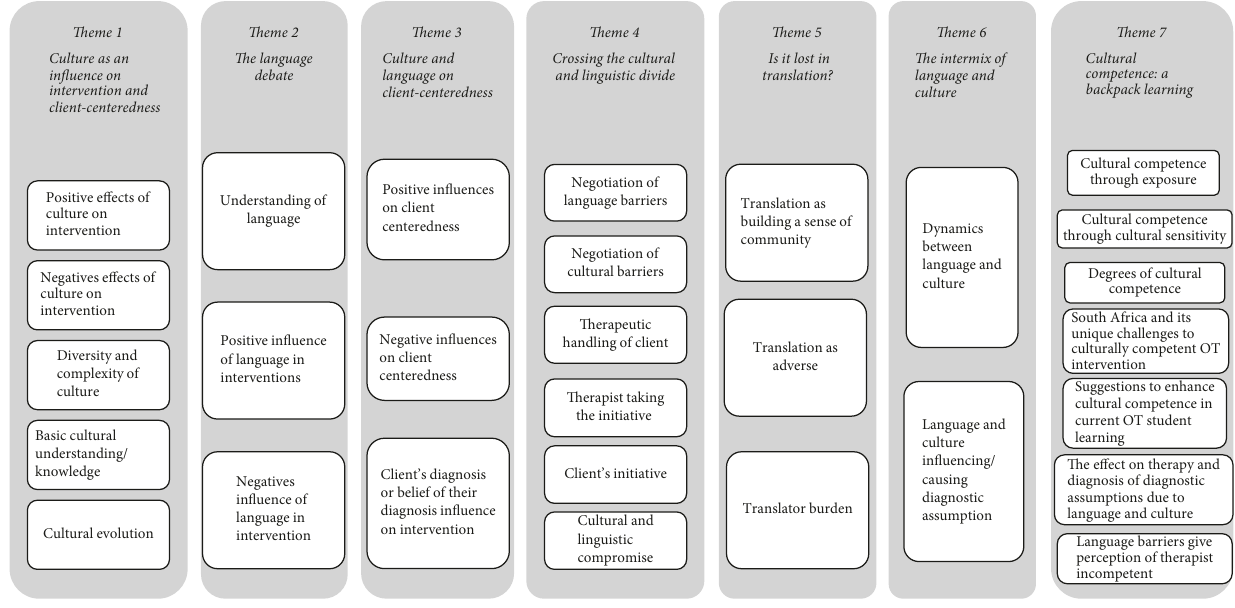
Figure 4: Themes and